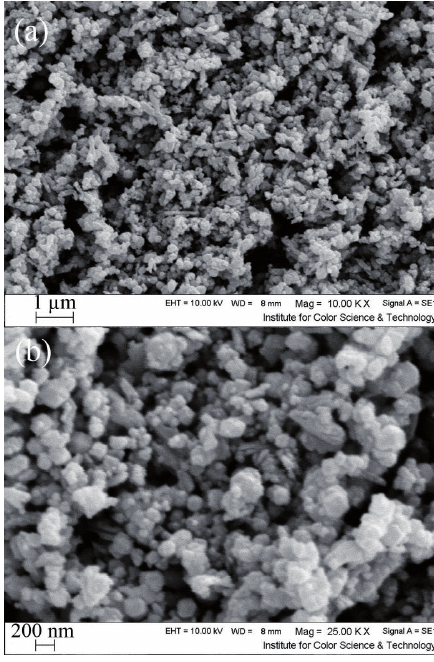
Figure 4. XRD pattern of (a) Sb 2 O 3 nanoparticles, and (b) PMMA/Sb 2 O 3 -Br. Figure 5. SEM images of Sb 2 O 3